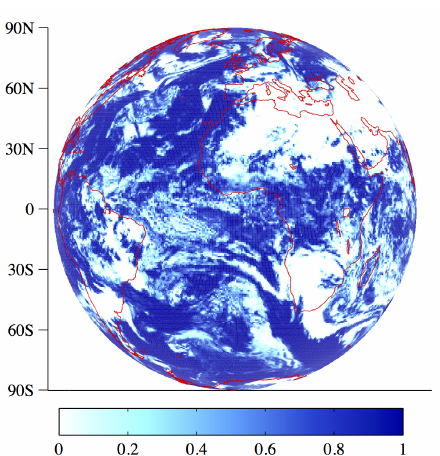
Figure 2. Simulated Earth Polychromatic Imaging Camera (EPIC) view from the cloud field produced by the Nature Run at 1200 UTC on 25 September